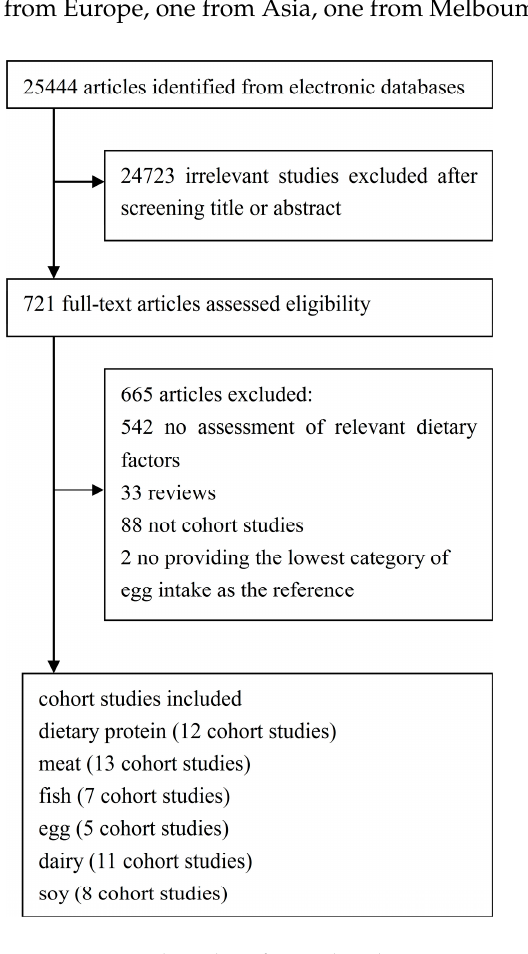
Figure 1. Flow chart for study selection.